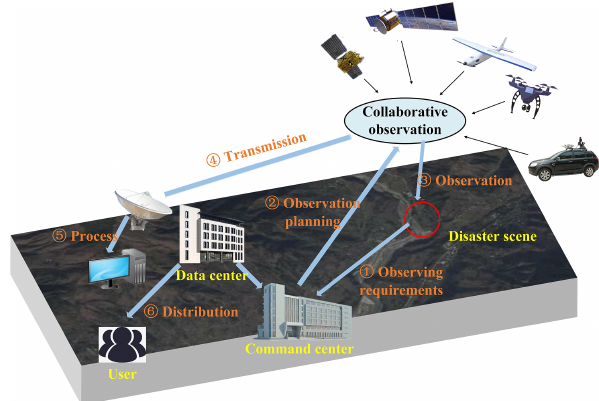
Figure 1. Collaborative remote sensing observation service system for geohazard emergency